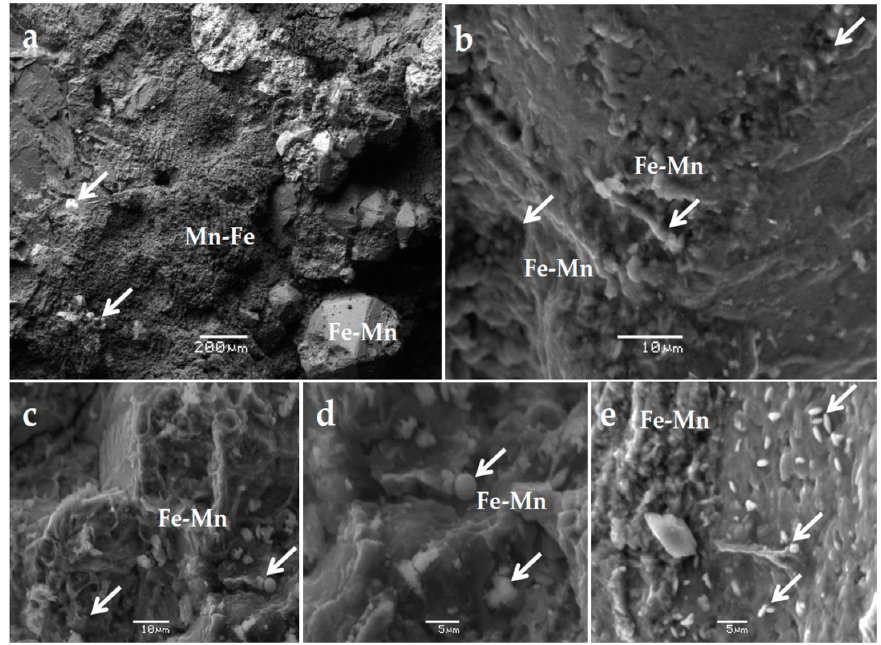
Figure 4. Representative secondary images of unpolished Fe-Mn hard dark brown-black crusts from the Legrena valley showing ( a ): Rounded fragments to spherical of Fe-Mn porous ore, cemented by dark brown-black Mn-Fe mineralization; ( b – e ): Ball-shaped Fe-Mn nodules, aggregates of vestiges and holdfasts (white arrows) are common.